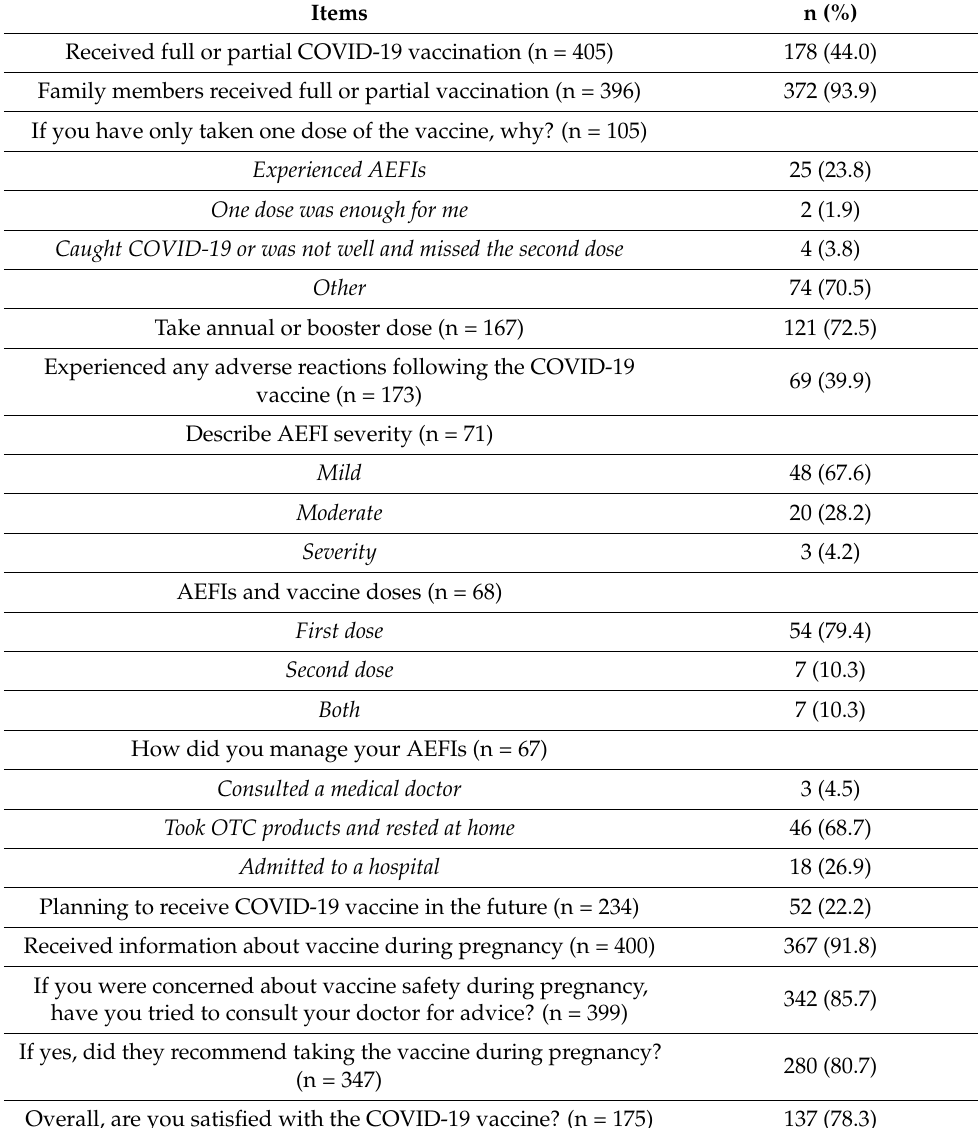
Table 2. Vaccination status and participants’ experiences with the COVID-19 vaccine.